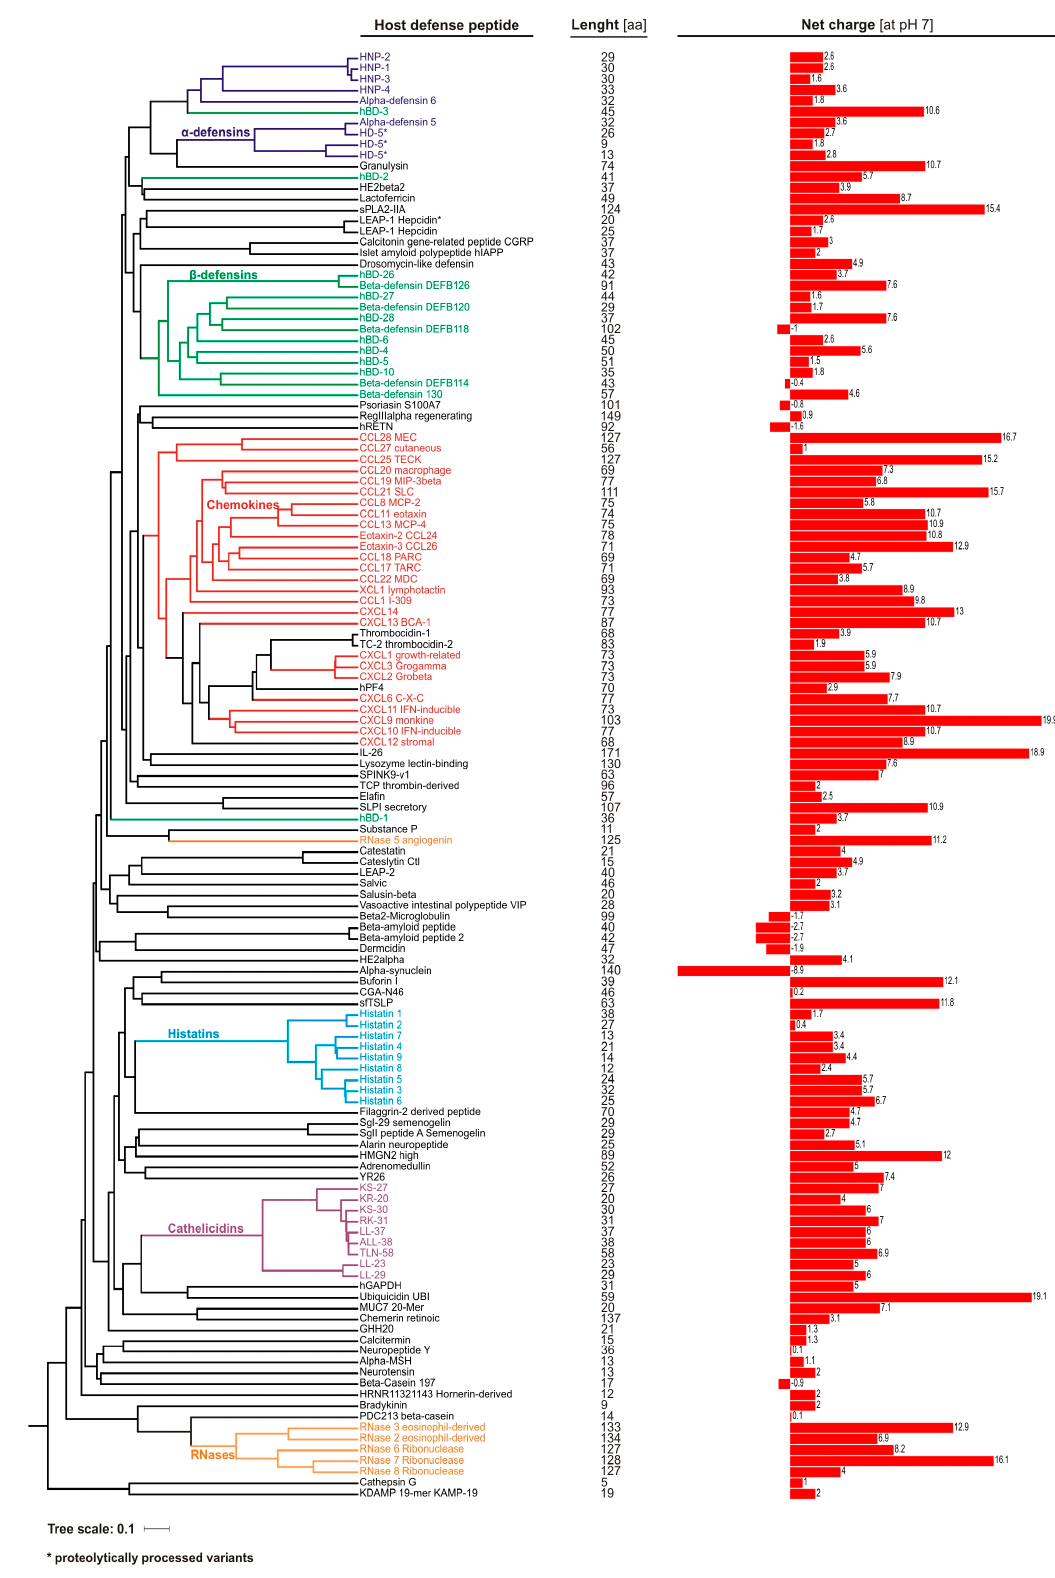
Figure 2. Comparison of human host defense peptides ( n = 133) curated in antimicrobial peptide database (http://aps.unmc.edu/AP; accessed in September 2019). The dendrogram was built based on amino acid sequence alignment using MAFFT aligner (https://mafft.cbrc.jp) [65], visualized and annotated with Archaeopteryx [66] and iTOL [67], respectively. Net charge values of the peptides (at pH = 7.0) were estimated using Protein Calculator https://pepcalc.com/protein-calculator.php [68].